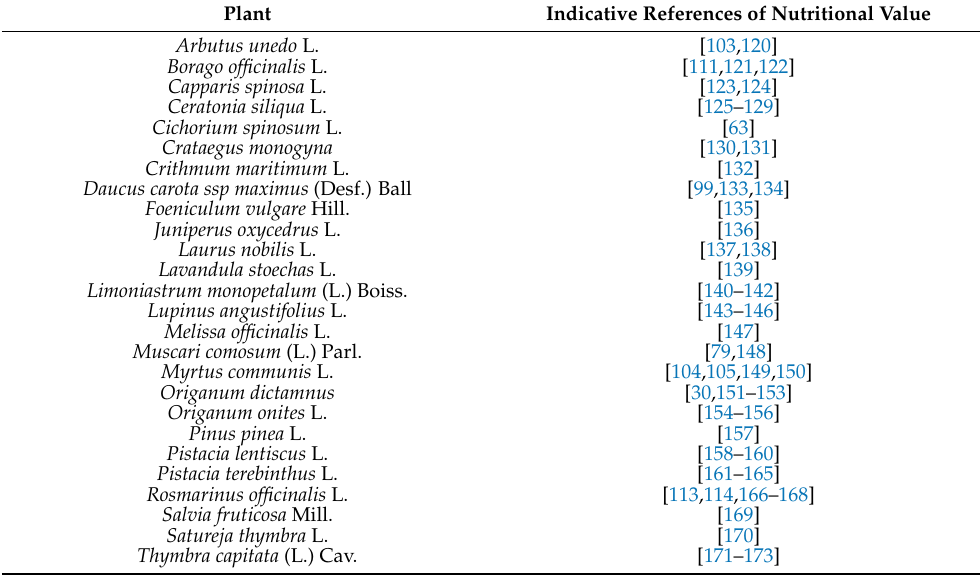
Table 3. Nutritional use of Mediterranean plants in the literature. Plant Indicative References of Nutritional Value Arbutus unedo